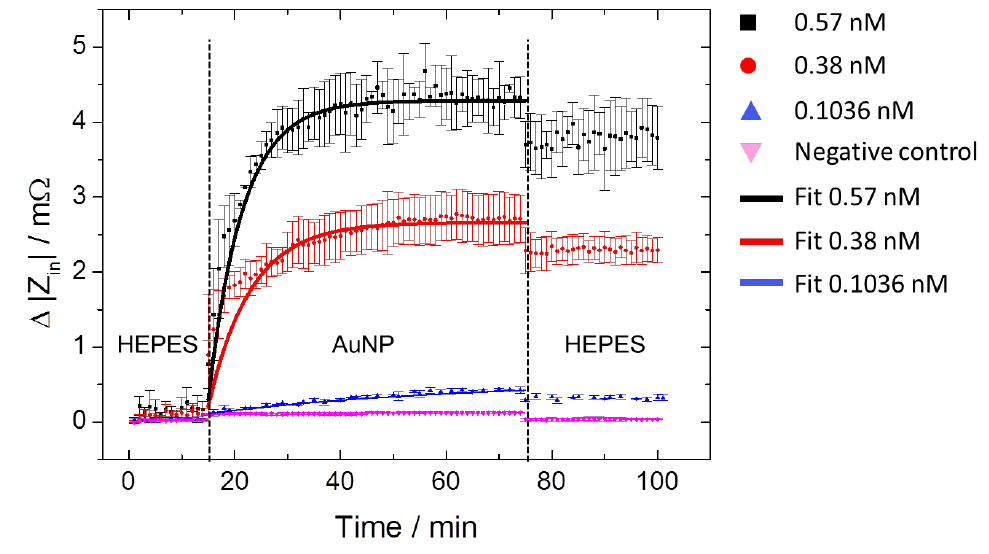
Figure 6. Time-resolved measurements of ∆ |Z in | for three MPA–AuNP concentrations. The blue (upturned triangle), red (dots), and black (squares) curves correspond to the increased MPA–AuNP concentrations of 0.1036 nM, 0.38 nM and 0.57 nM, respectively. A negative control was carried out (pink downturned curve), showing no change of impedance. Exponential fit curves were calculated to determine the characteristic values (see Table 1 for fit parameters).